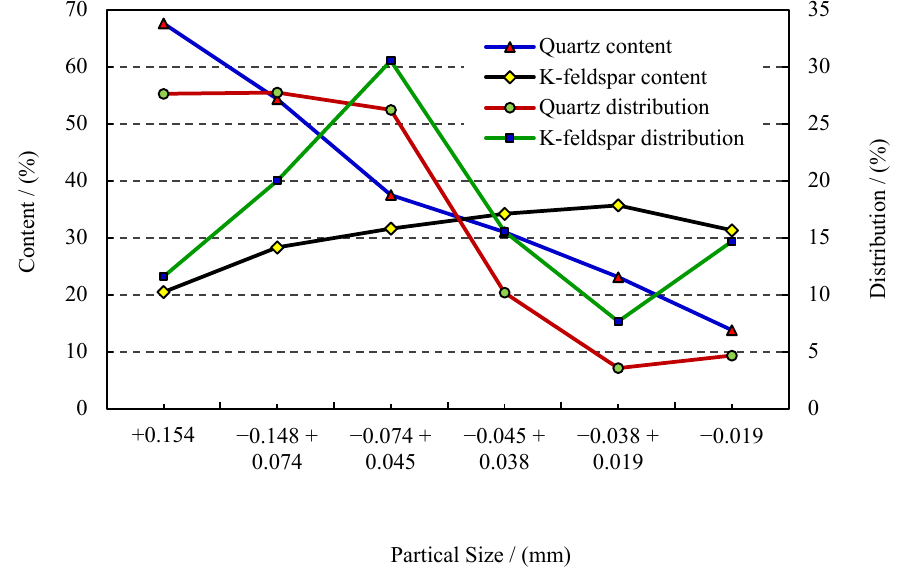
Figure 5. Main mineral composition in tailings samples with different particle sizes.